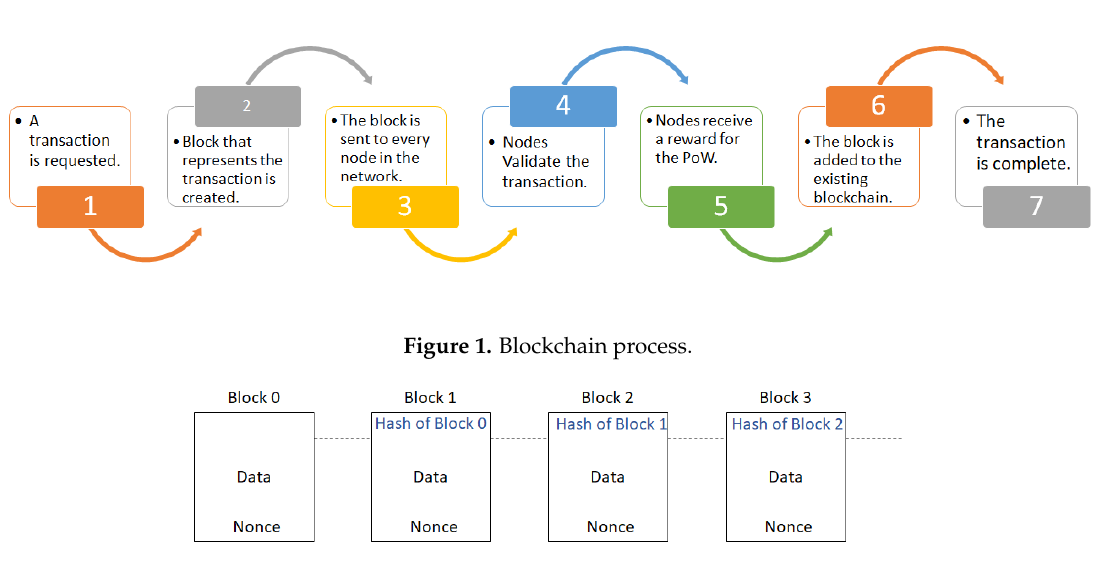
Figure 2. Blockchain: A chain of blocks where each node references the previous block. POW = Proof of